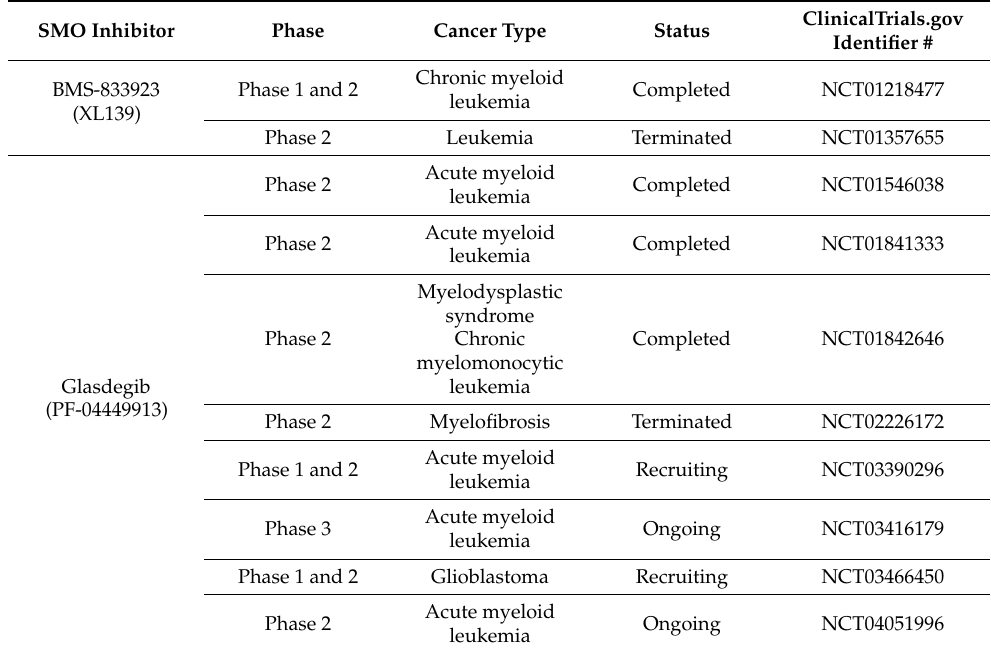
Figure 3. Chemical structures of the selected SMO inhibitors. Table 1. SMO inhibitors under clinical trials in patients with various types of cancer. Data from https://clinicaltrials.gov (accessed on 30 August